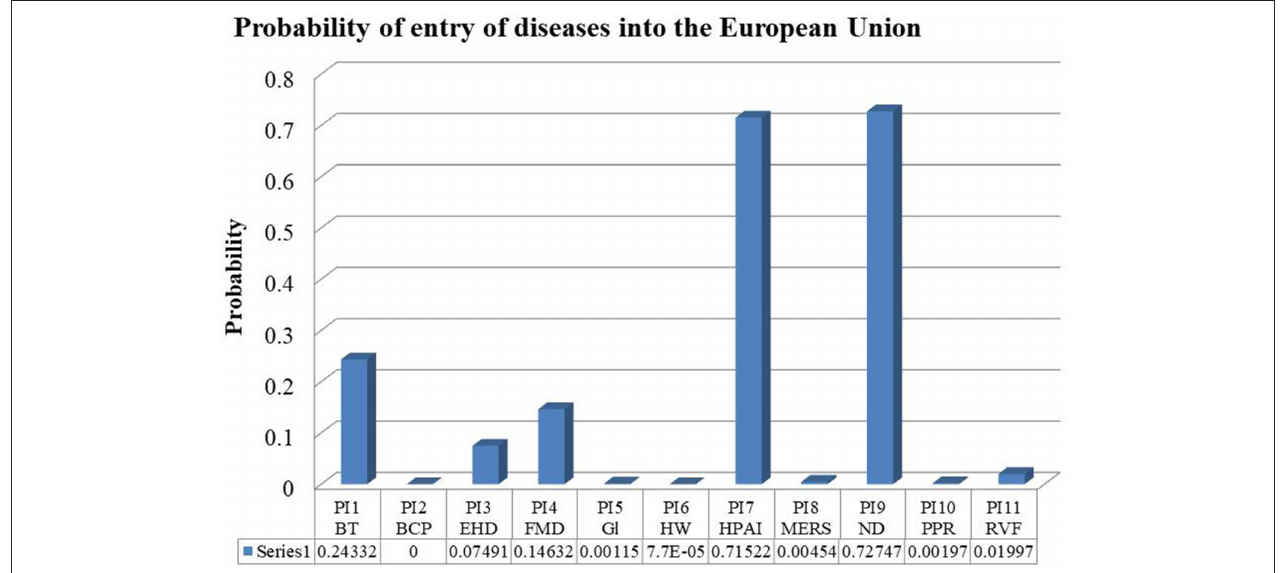
FIGURE 3 | Likelihood of entry of each disease in the European Union (PI: Probability of Introduction). Disease 1: bluetongue; 2: bovine contagious pleuropneumonia; 3: epizootic haemorrhagic disease; 4: foot and mouth disease; 5: glanders; 6: heartwater; 7: highly pathogenic avian influenza; 8: Middle East respiratory syndrome; 9: Newcastle disease; 10: peste des petits ruminants; 11: Rift Valle